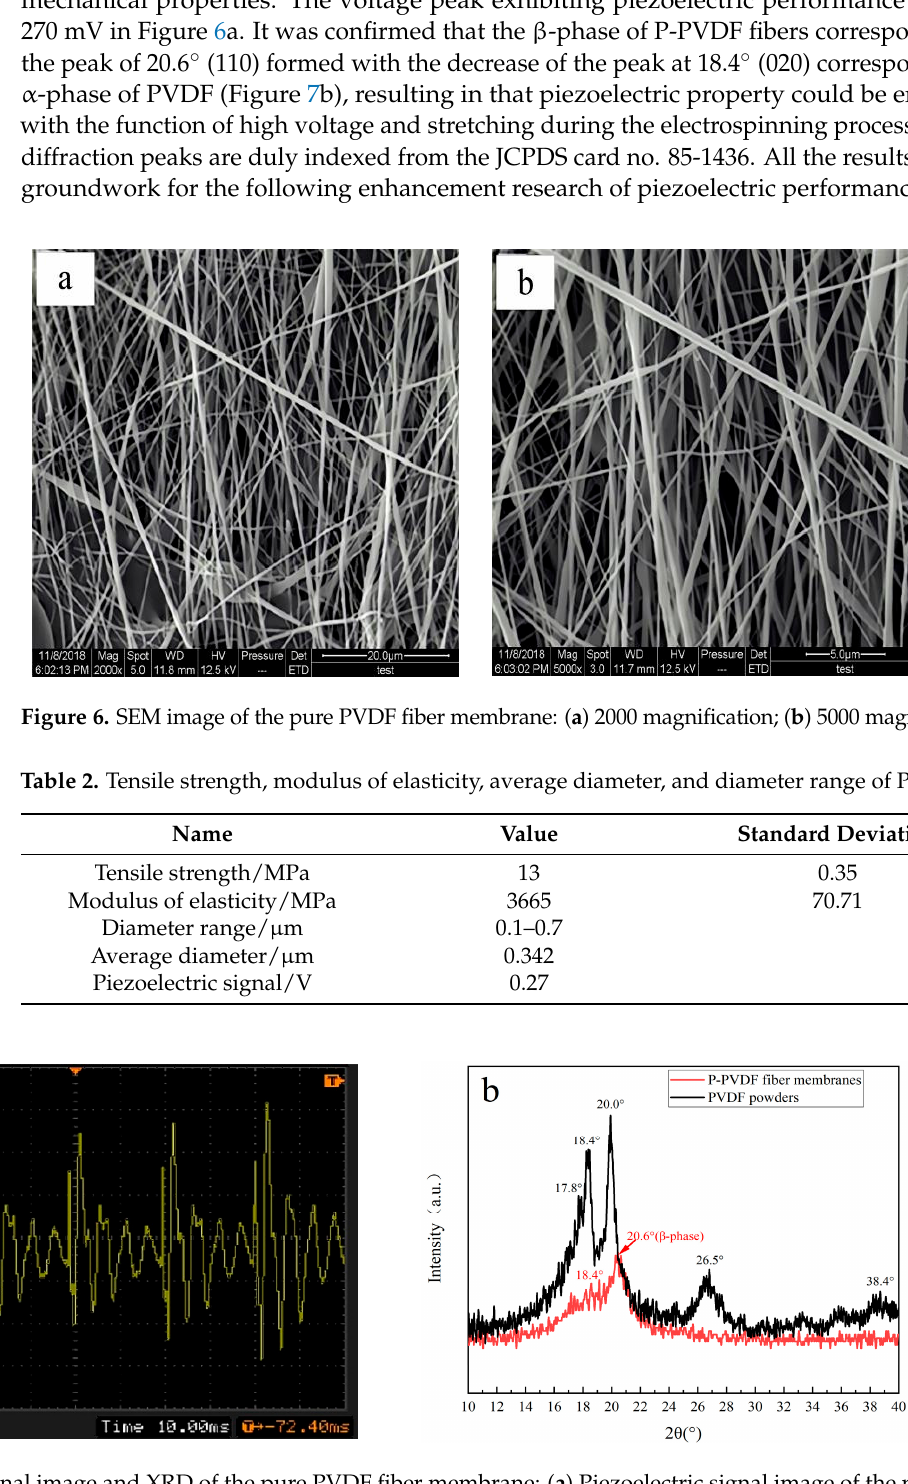
Figure 5. Waveform of the mechanical vibrations.